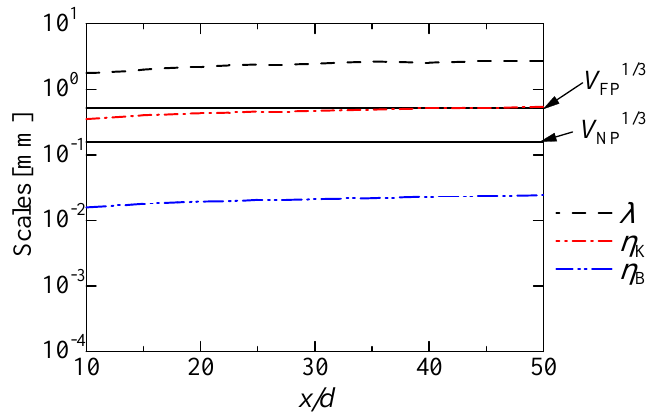
Fig. 9 The probe resolutions and characteristic length scales in the planer jet on the jet centerline. The Taylor microscale (cid:21) (black dashed line), the Kolmogorov scale (cid:17) K (red dashed dotted line) and the Batchelor scale (cid:17) B (blue dashed double-dotted line) obtained by Watanabe et al. (2012) are shown together. intensity than the halogen lamp used in the former